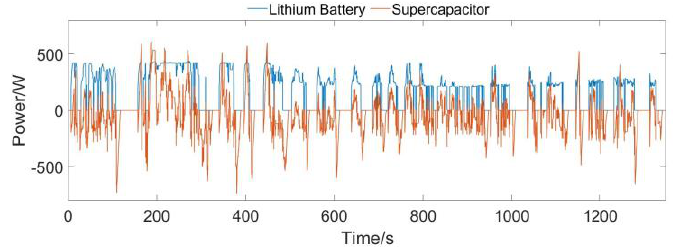
Figure 6. Output power under Q-learning strategy.